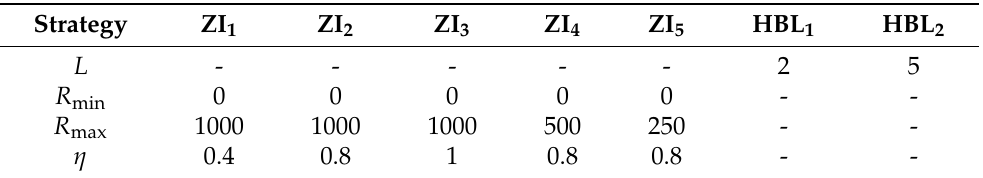
Table 4. A set of basic background trading strategies that we include to compare to the two HBL